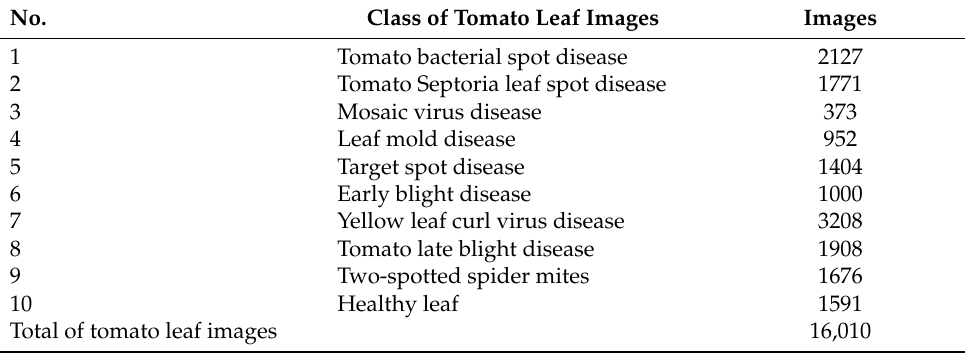
Table 1. The total tomato leaf images used in this